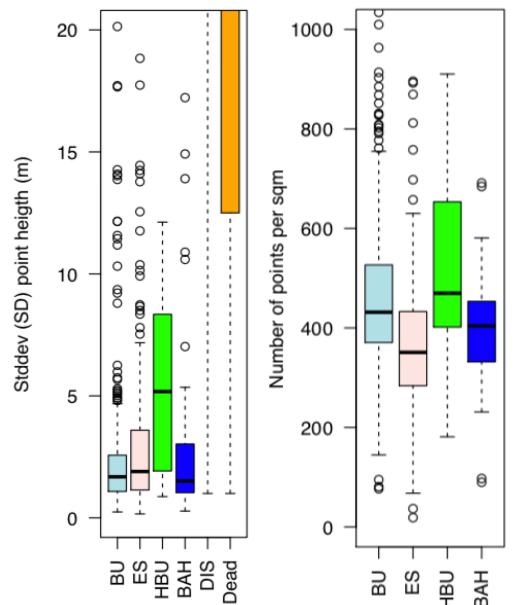
Figure 7: Variability of the point cloud height information sampled over 2.5 x 2.5 m 2 plots for the dominating tree species (beech (BU), ash (ES), maple (BAH), hornbeam (HBU) and defoliated / dead tree